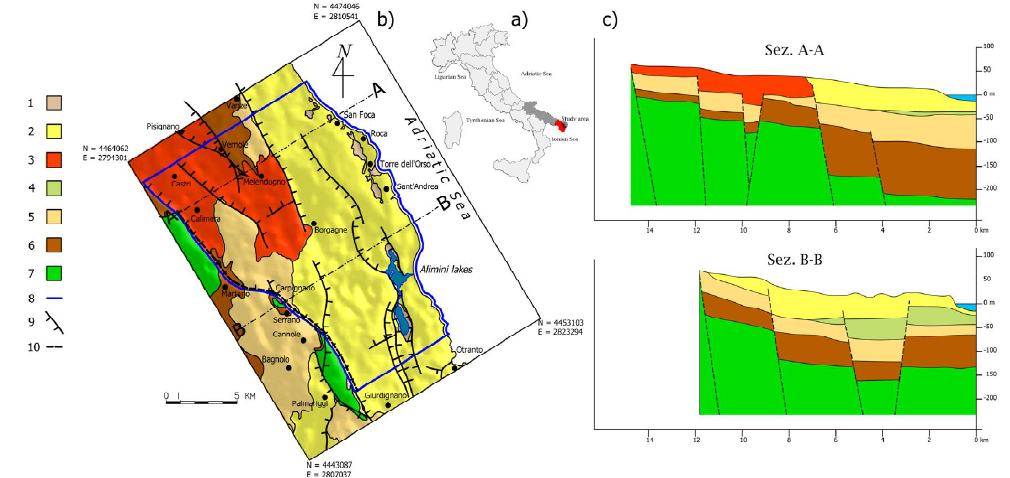
Fig. 1. (a) Location of study area; (b) Geologic map: (1) Alluvial sand and loam, (2) coarse-grained sandstone (sabbie di Uggiano), (3) sand with sandstone layers interbedded (Calcareniti di Gravina), (4) sandy-clay and clay marl (Argille Subappenniniche), (5) medium- grained calcarenite with marly limestone layers interbedded (Calcareniti di Andrano), (6) marly fine-grained sandstone (Pietra Leccese), (7) fractured limestone and dolomitic limestone (Calcare di Altamura), (8) domain contour line, (9) faults, (10) Serre Salentine; c)extrapolated cross sections.